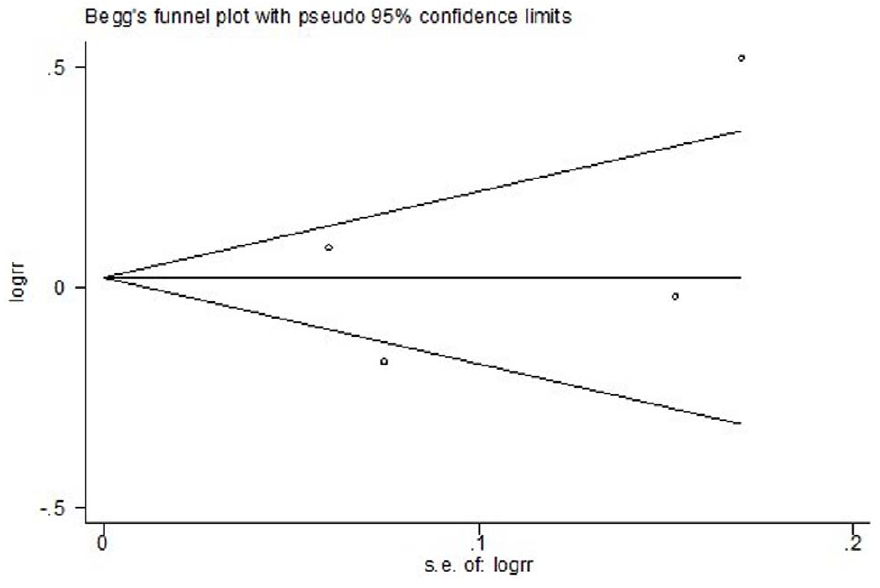
Figure 9. Funnel plot for publication bias test of ORR. The two oblique lines indicate the pseudo 95% confidence limits.